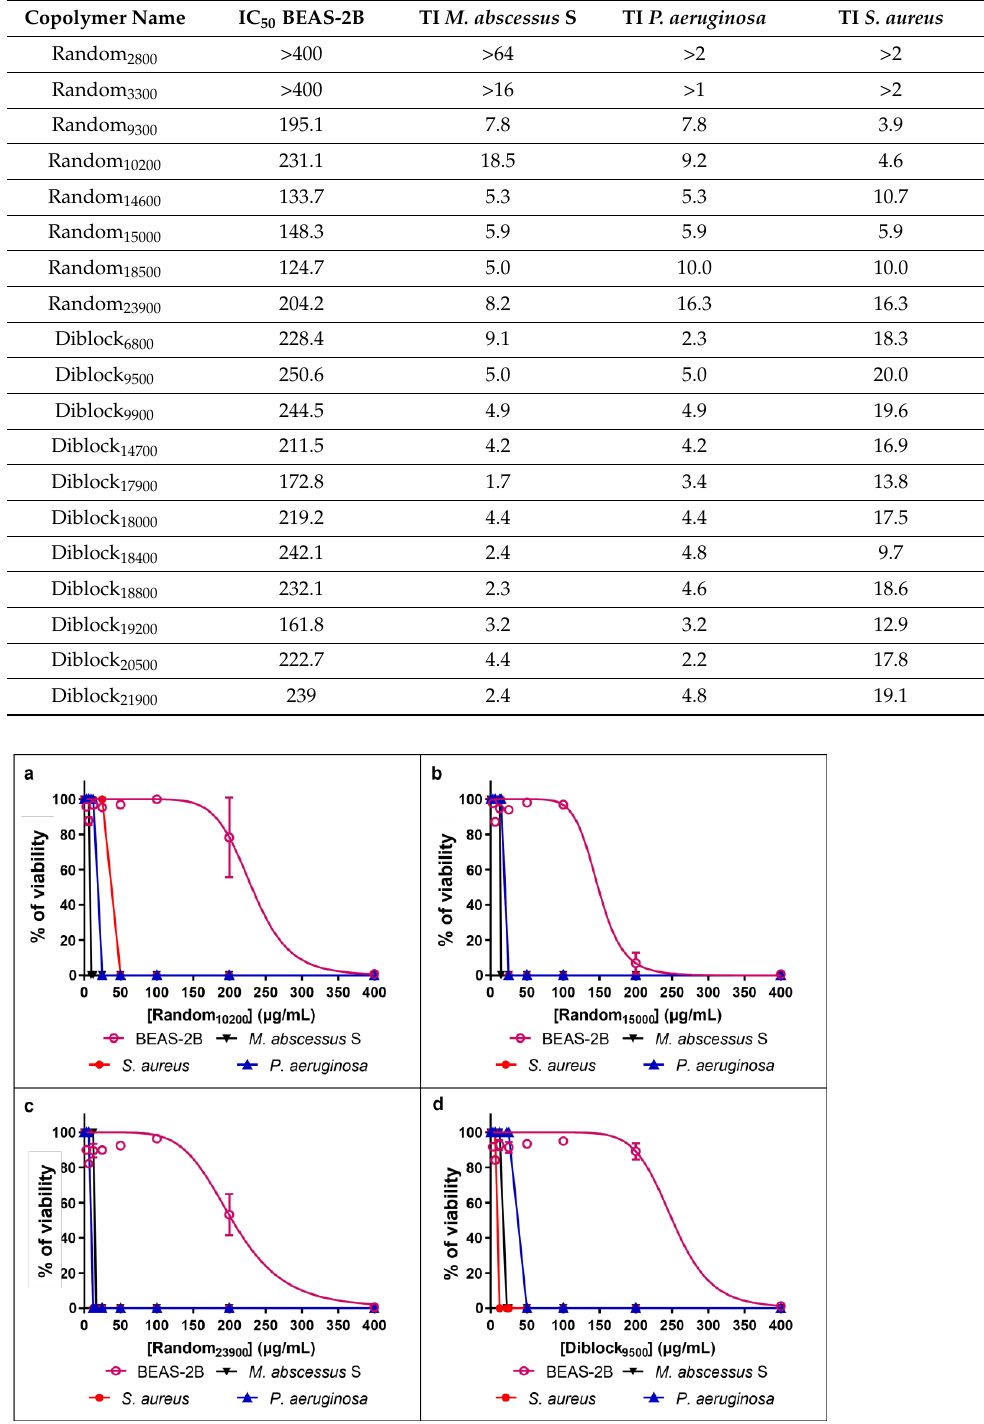
Figure 3. Comparative toxicity and antibacterial activity of the selected copolymers. The four more interesting copolymers, i.e., Random 10200 ( a ), Random 15000 ( b ), Random 23900 ( c ), and Diblock 9500 ( d ), were tested in terms of toxicity on human cells (BEAS-2B cells) and activity on bacteria. Results are expressed as the mean ± SD of the percentage of cell viability (n = 3).